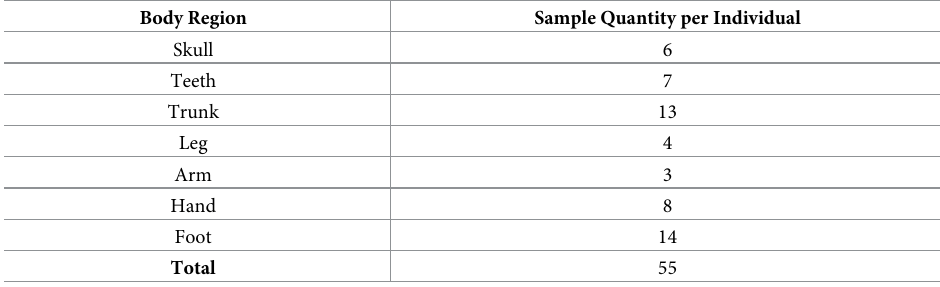
Table 1. Number of bones sampled by body region for each of the three